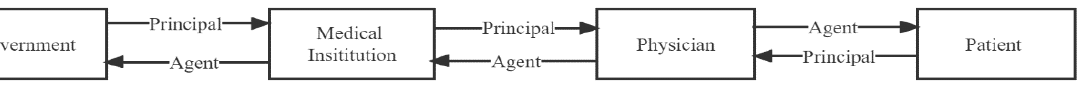
Figure 1. Theoretical framework.